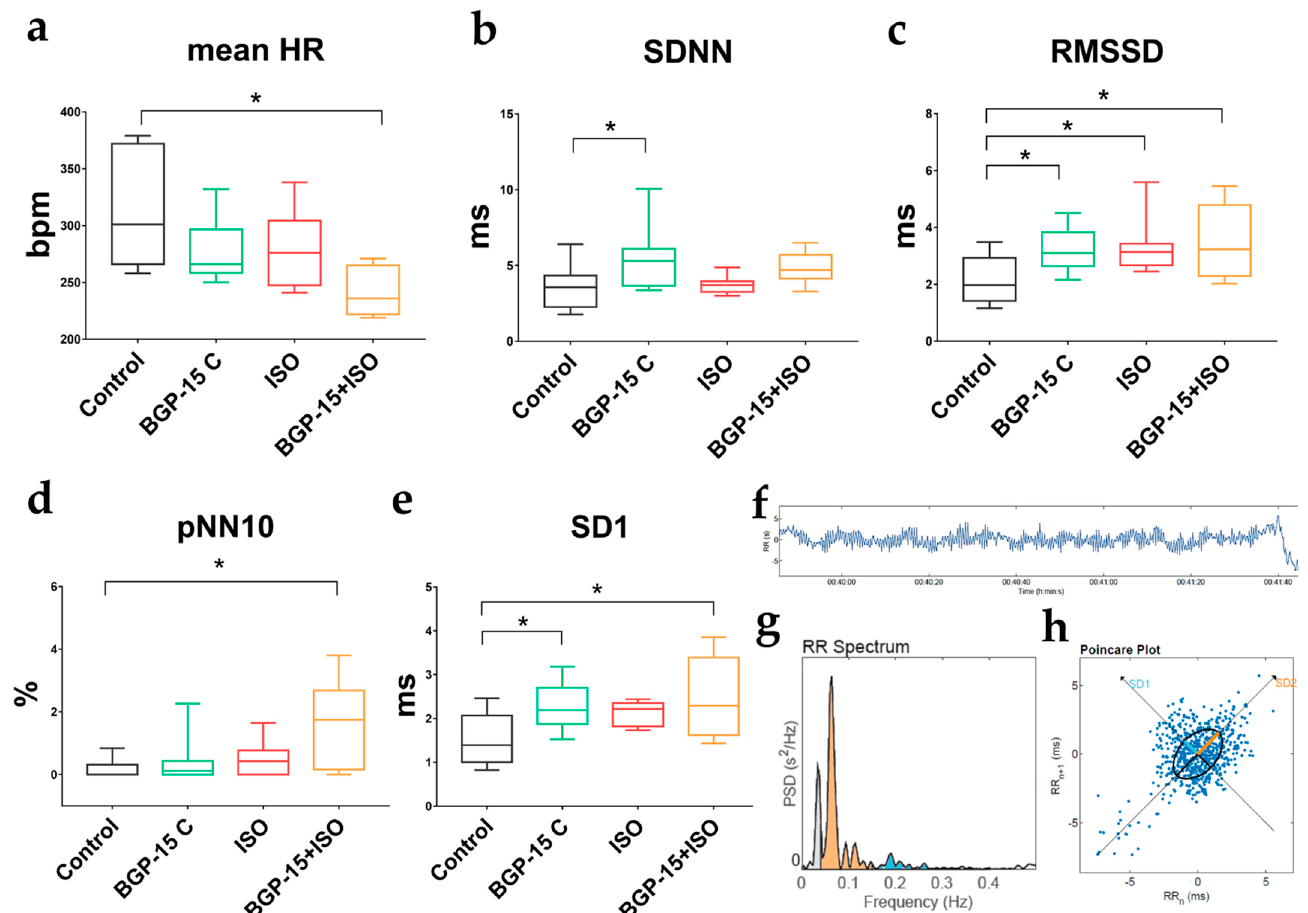
ISO on Ca 2+ -transient amplitude (Figure 5g) ( p = ns, BGP-15 vs. BGP-15+ISO). Interestingly, BGP-15 treatment increased the resting (diastolic) sarcomere length ( p = 0.0342, Figure 5e) of the isolated cardiomyocytes.